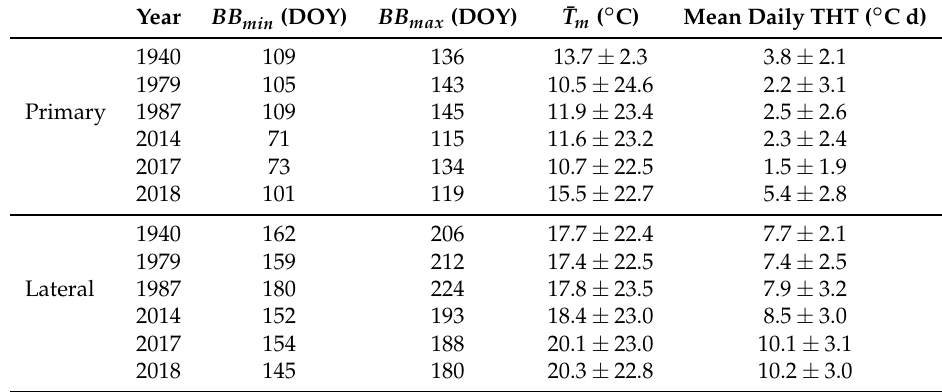
Table 2. Bud break statistics per year: Range of Dates (first BB min and last BB max ) and average daily mean temperature ( ¯ T m ).